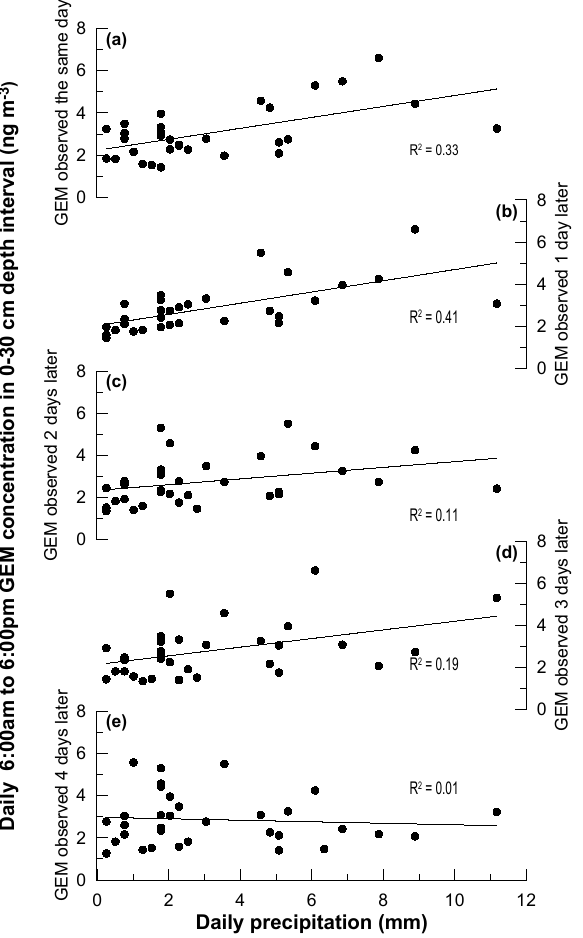
Fig. 5. GEM concentration observed in the upper snowpack layer (0–30cm depth) from 6.00a.m. to 6.00p.m. and averaged daily, as a function of the daily amount of precipitation (in liquid water equiv- alents). GEM observed the same day (a) , a day after (b) , two days after (c) , three days after (d) , and four days after (e) . Data from the entire 2009 measurement campaign (i.e., from DOY 37 to 128) are